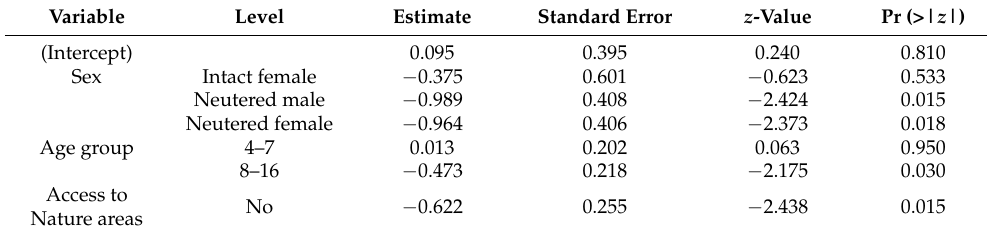
Figure 1. Geographical distribution of the 97 companion cats tracked in Denmark. Based on map data provided by The Danish Agency for Data Supply and Efficiency, Copenhagen, Denmark, and Danish Municipalities; ‘DAGI’ (downloaded 08/2020). Table 1. Final model for percentage of time spent away from home base. The pseudo-R-squared of the model was 0.25. In comparison, the full model, including all variables, had a pseudo-R-squared of 0.30. The reference category (intercept) consisted of intact male cats in the age group 1–3 years with access to nature